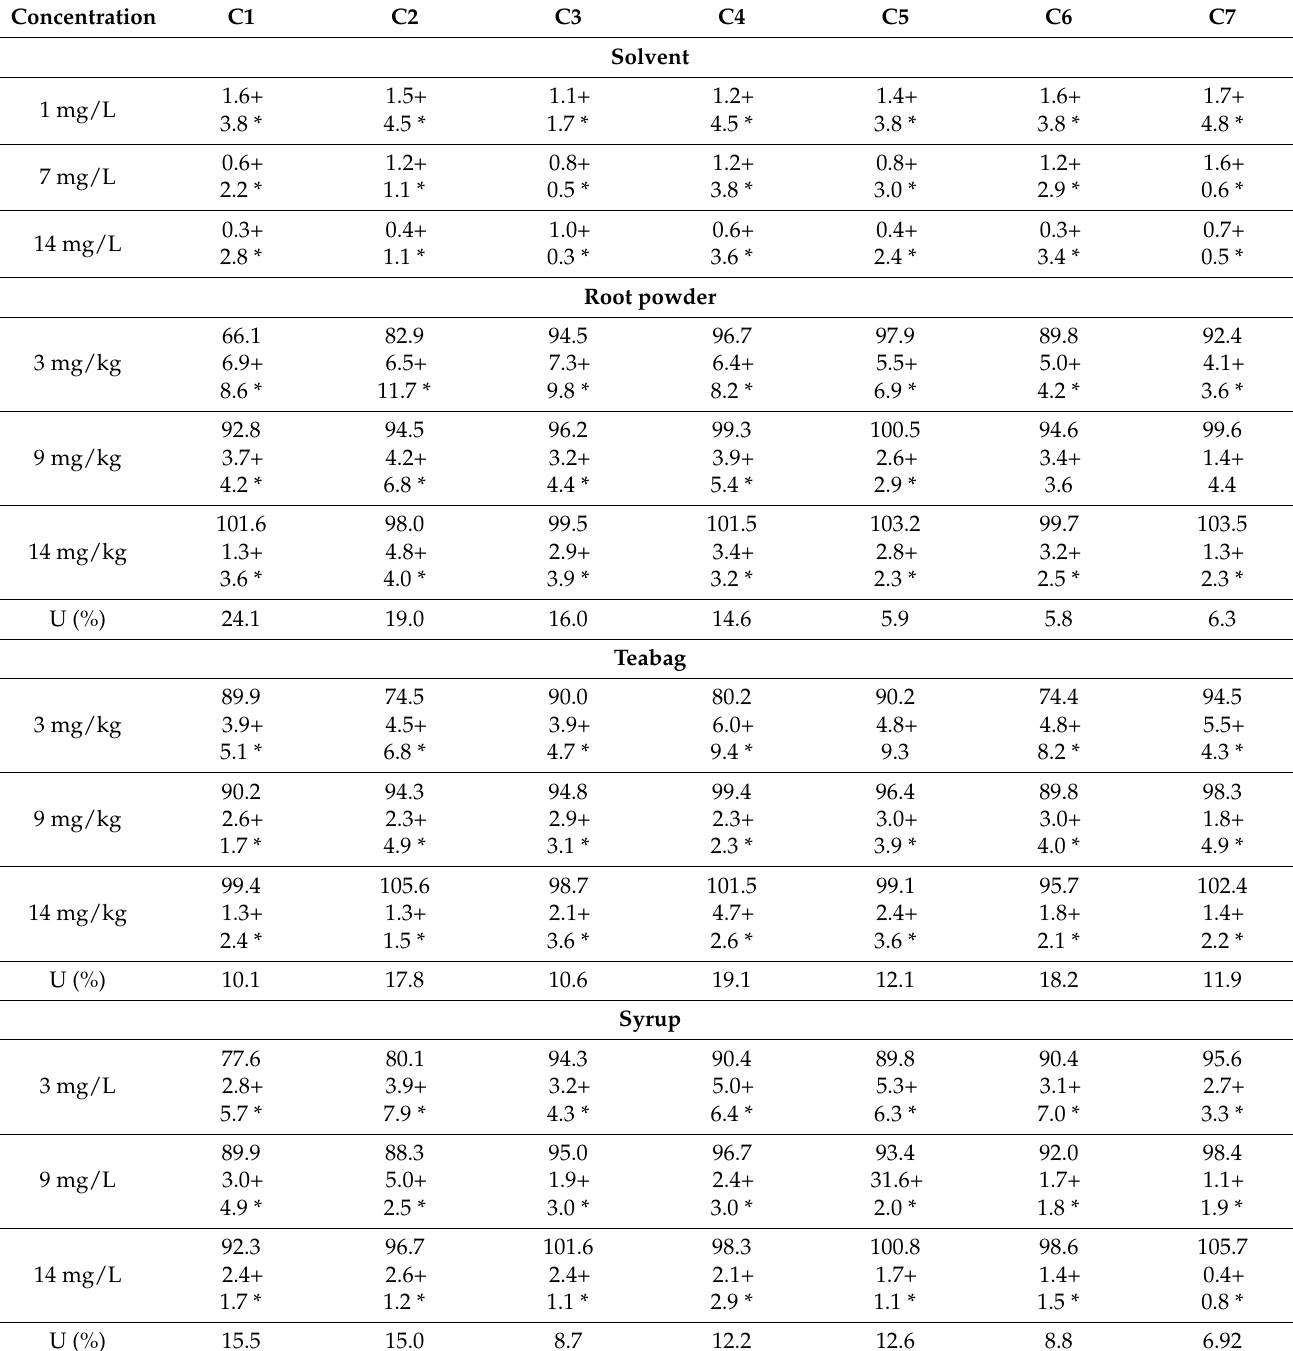
Table 4. Percentage recoveries, intra-day+ and inter-day * precision (%RSD), and measurement uncertainty (expressed as U (%)) data for the compounds in solvent and the different